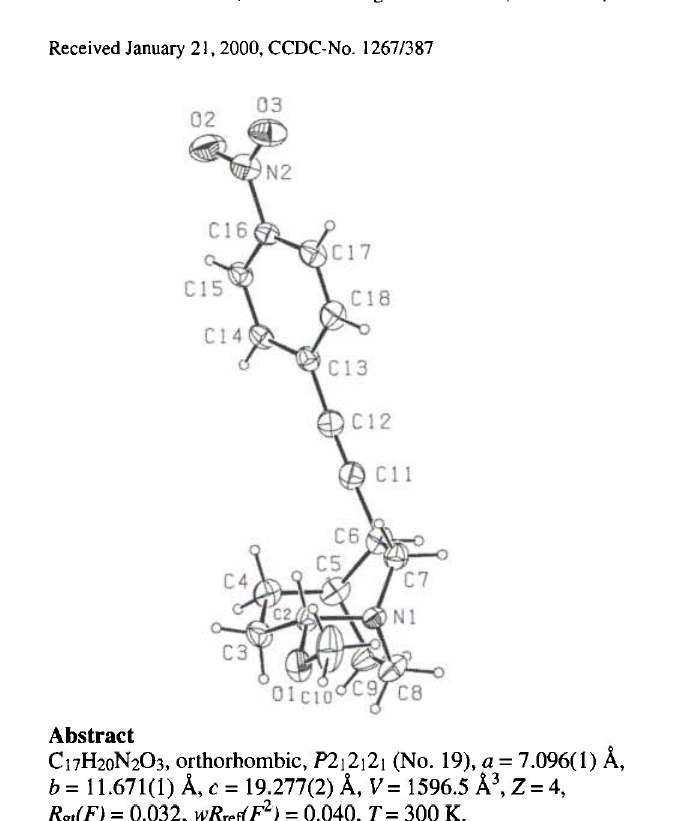
Table 1. Data collection and